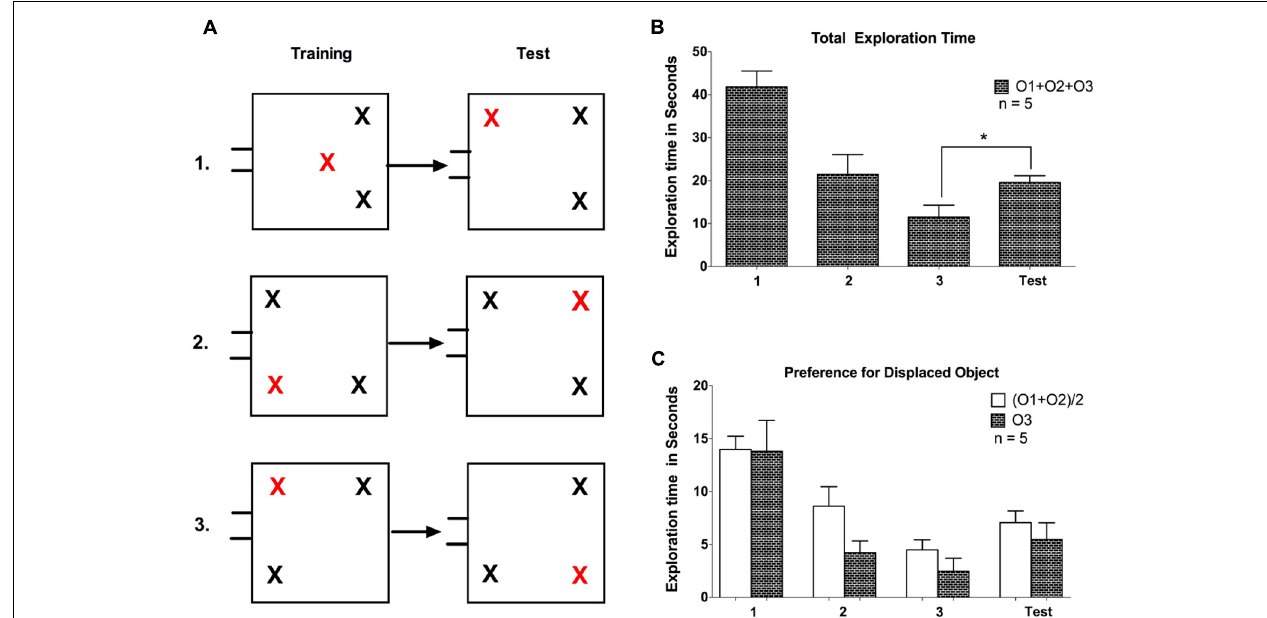
FIGURE 2 | (A) Representation of training and test phases for the three configurations used in Experiment 1. All the objects were identical; the red cross marks the to-be displaced object in the trainings sessions and the displaced object during the test session. (B) The total exploration time spent